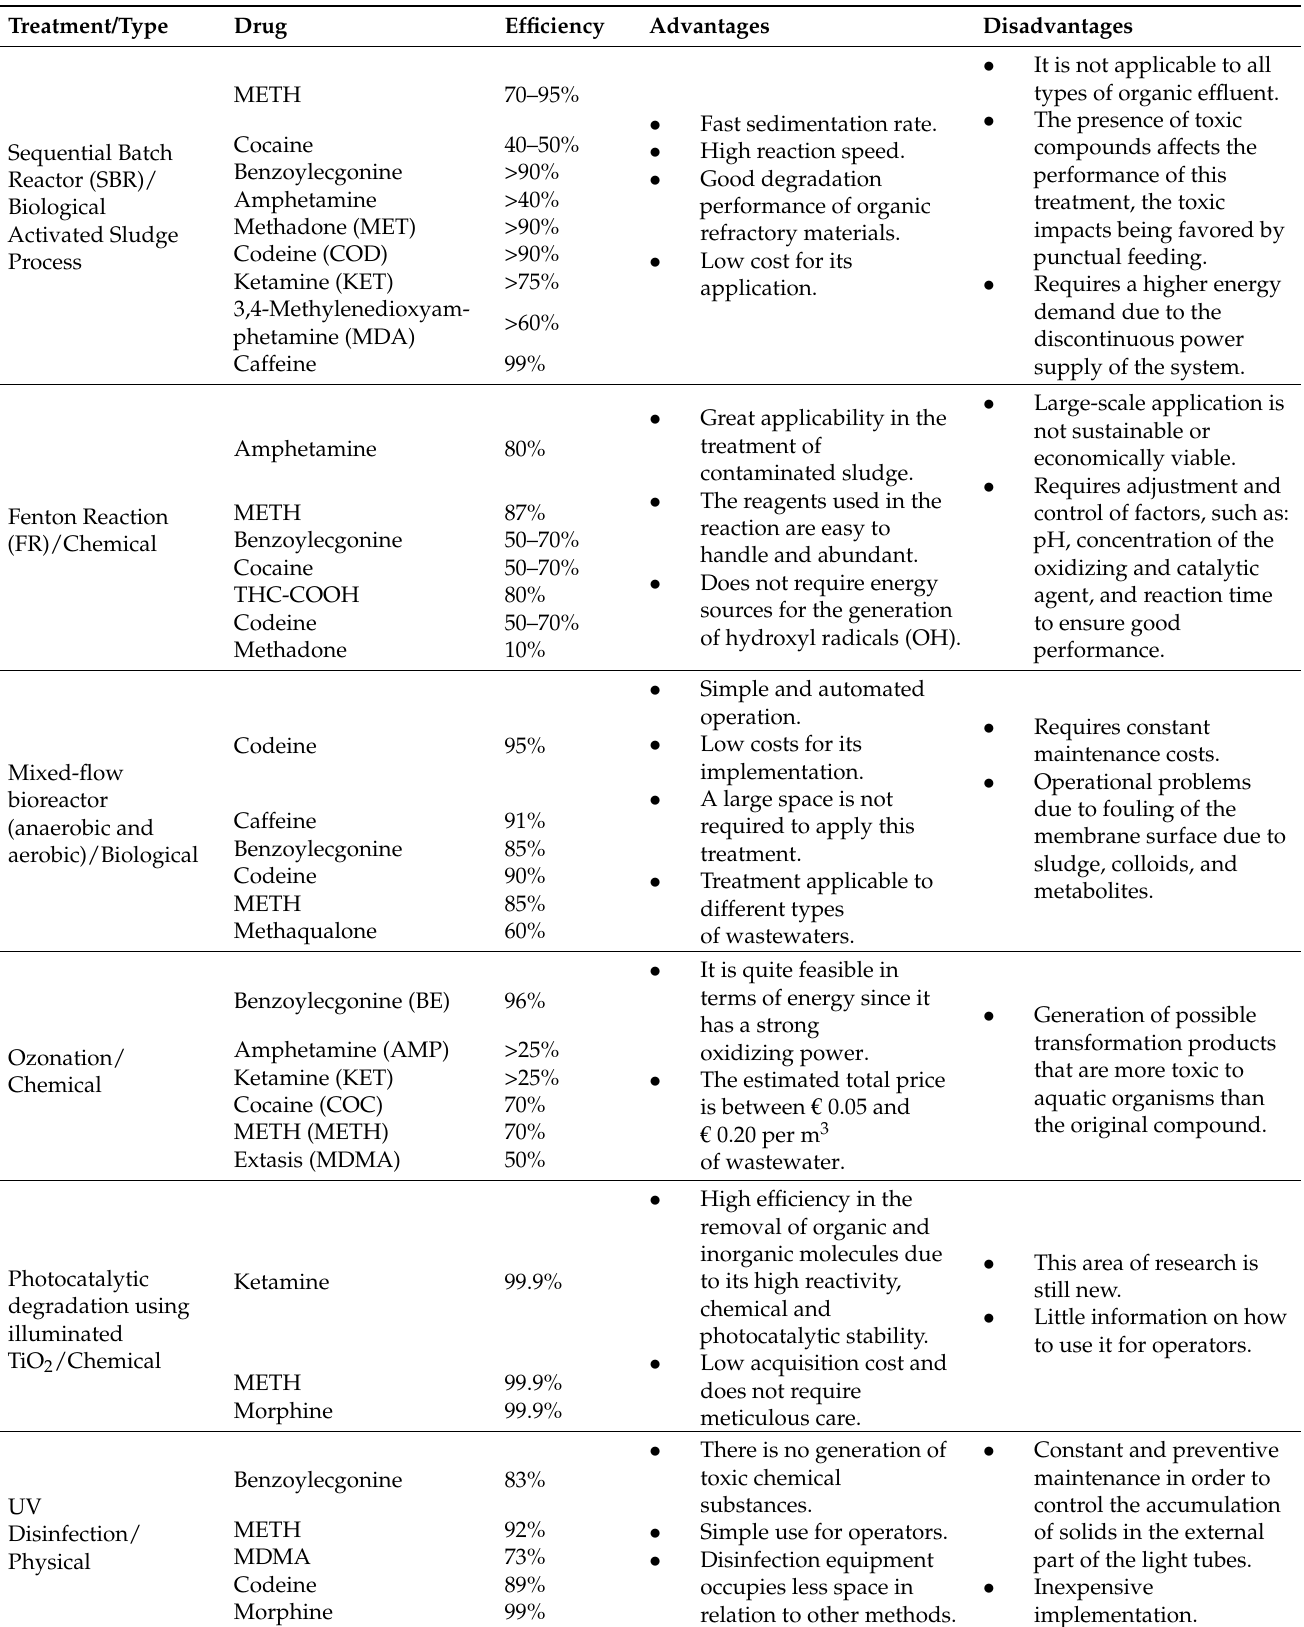
Table 3. Advantages and disadvantages of treatments for the removal of drugs of